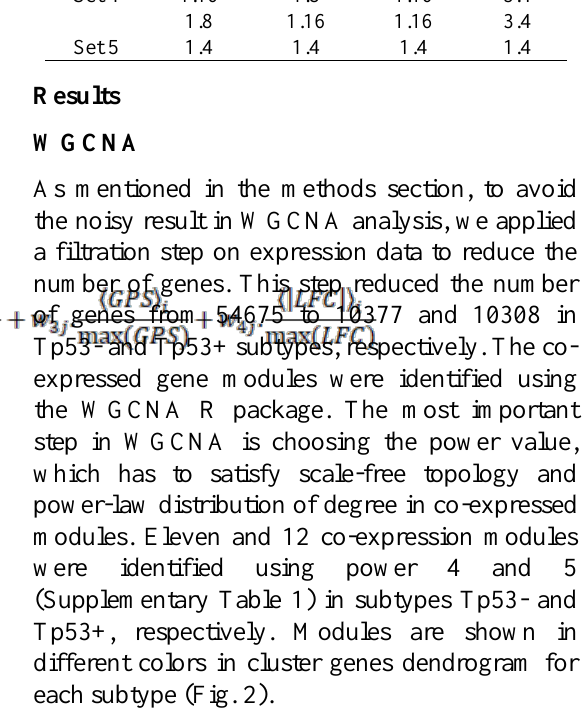
(Supplementary Table 1) in subtypes Tp53-